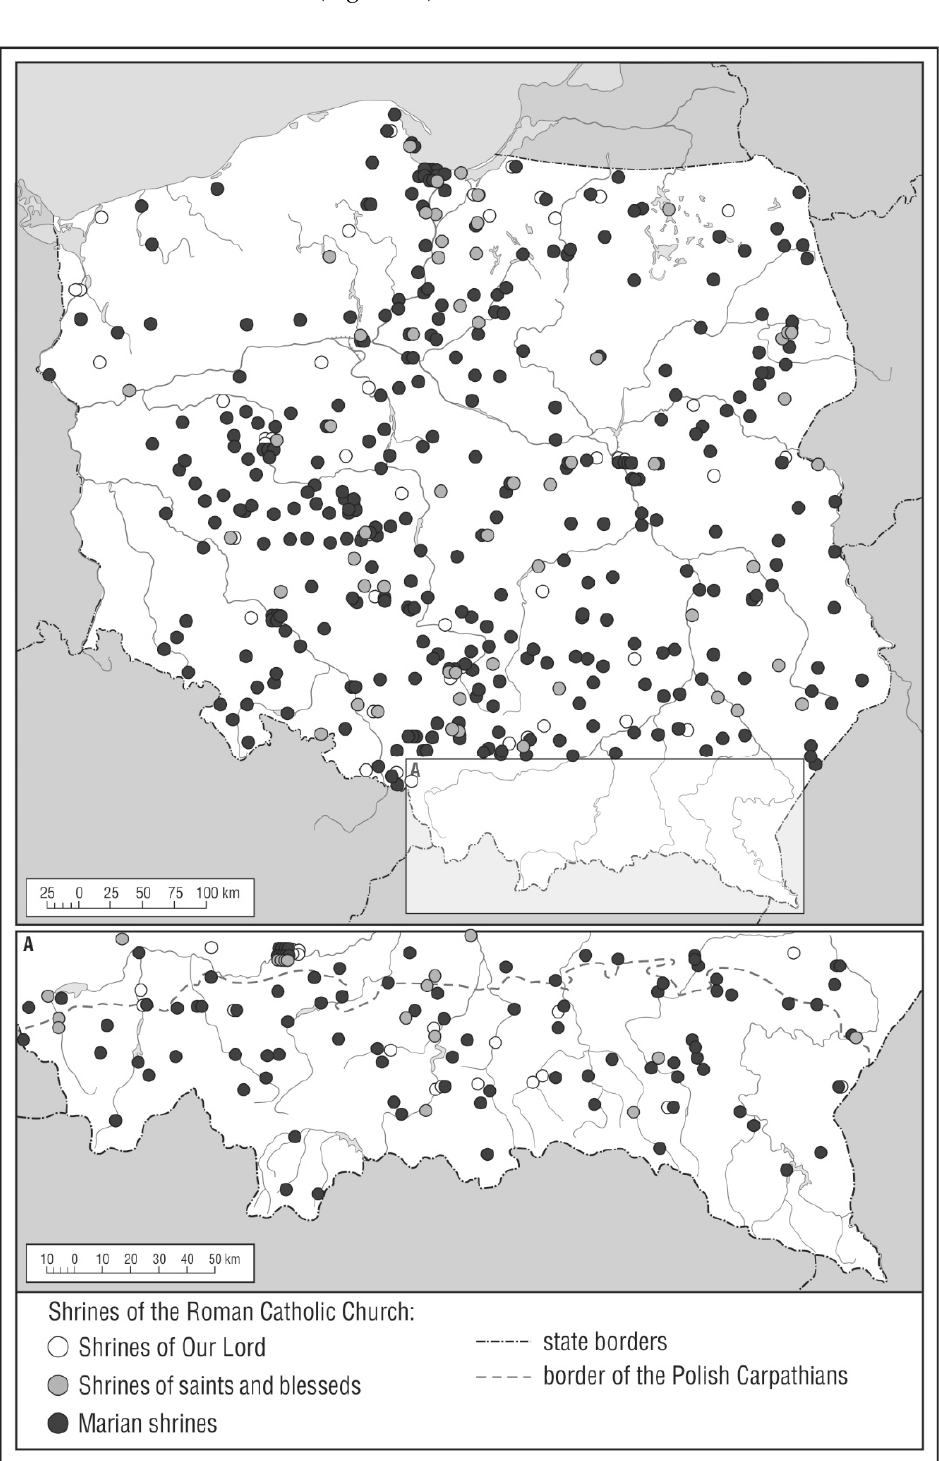
Figure 16. Shrines of the Catholic Church in Poland in 1998. Source: author.